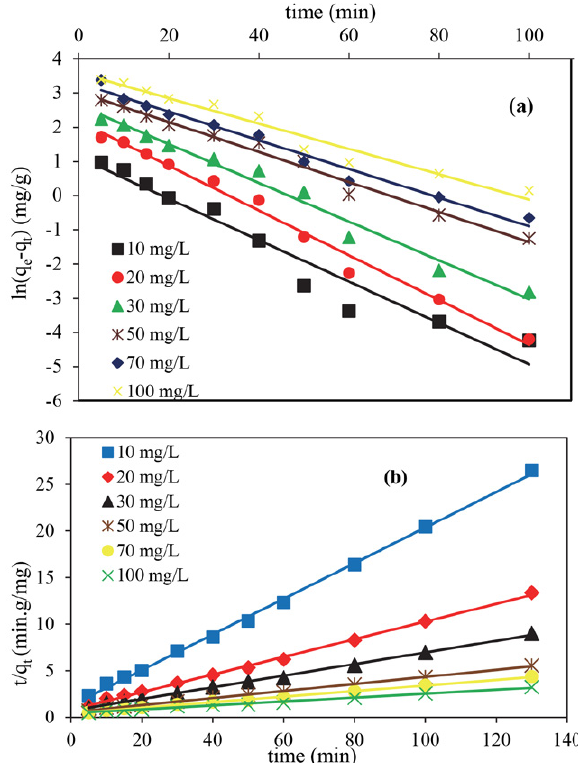
Figure 11. Sorption kinetics of P ions using MnFe 2 O 4 nanoparticles in different concentrations of P ion (10–100 ppm) and different contact times (5–130 min), including the PFO model (a) and PSO model (b) (Other conditions: adsorbent dosage = 2 g/L, tempera- ture = 55 °C, mixing rate = 500 rpm and pH =